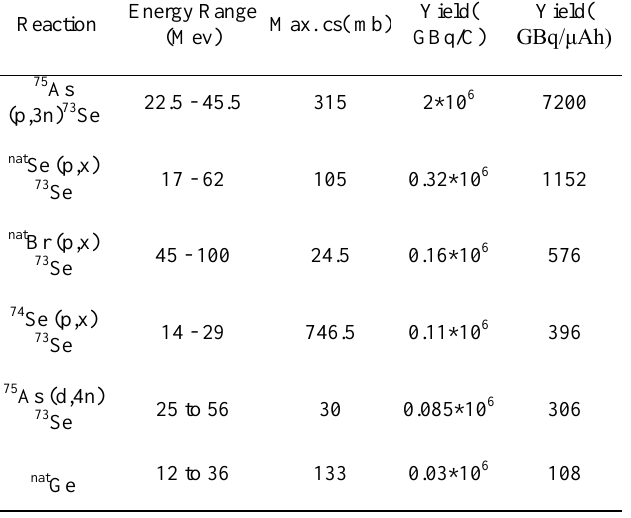
Table 1: Nuclear data of 73Se production by various nuclear reactions